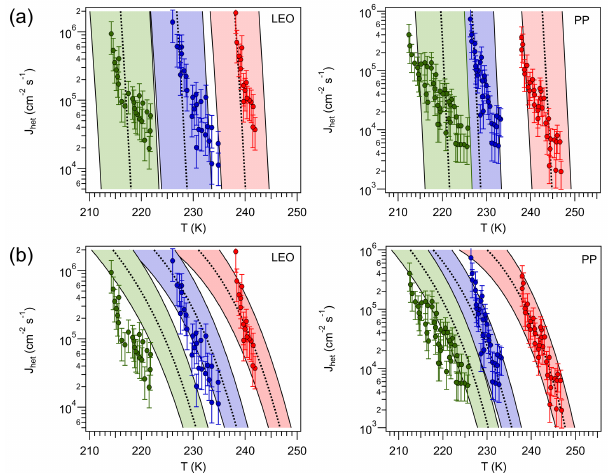
Figure 8. (a) Heterogeneous ice nucleation rate calculated using a constant shift in a w (black, dotted, lines) for leonardite (LEO, (cid:49)a w , het = 0 . 2703) and Pahokee peat (PP, (cid:49)a w , het = 0 . 2466). Red, blue and green colors correspond to a w equal to 1 . 0, 0 . 931 and 0 . 872, respectively, for LEO, and 1 . 0, 0 . 901 and 0 . 862 for PP. Shaded area corresponds to (cid:49)a w , het ± 0 . 025. Markers correspond to experimental measurements reported by Rigg et al. (2013); er- ror bars represent an order of magnitude deviation from the re- ported value. (b) : J het calculated for constant ζ = 0 . 949 for LEO and ζ = 0 . 952 for PP. The shaded area corresponds to a w ± 0 . 01 and ζ ± 0 .